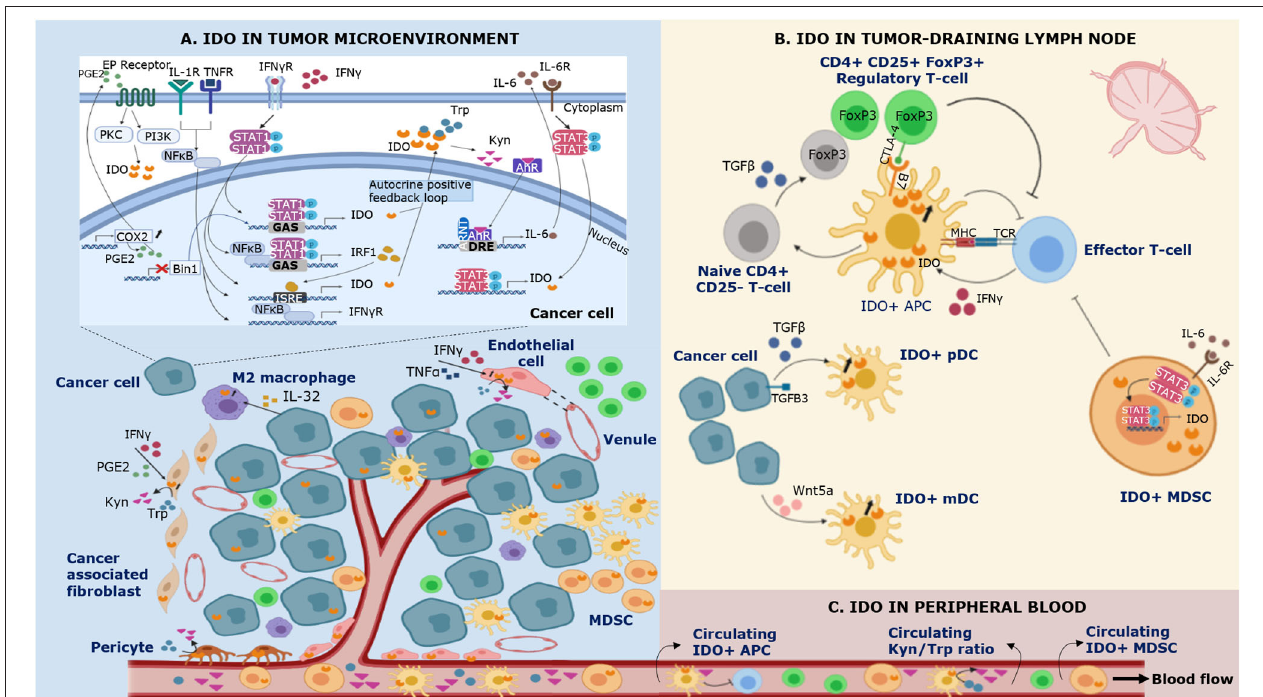
FIGURE 1 | Schematic representation of IDO expression in different compartments of the immune system during cancer. IDO is expressed by multiple cell types in the tumor microenvironment (A) , the tumor-draining lymph node (B) and the peripheral blood (C) . (A) Bin1 attenuation results in STAT1- and NF κ B-dependent constitutive expression of IDO in cancer cells. In addition, COX2 overexpression facilitates constitutive IDO expression via PGE2-mediated activation of the PKC/PI3K pathways. IFN γ is recognized as a highly potent inducer of IDO expression. Binding of IFN γ to its receptor (IFN γ R) leads to (i) tyrosine phosphorylation of STAT-1, triggering its dimerization and binding to the GAS sequence in IDO1 and (ii) NF- κ B and STAT-1 dependent synthesis of IFN γ -regulated factor 1 (IRF1), which binds to the ISRE sequences in IDO1 . Tumor IDO expression activates the cytosolic transcription factor aryl hydrocarbon receptor (AhR) by kynurenine (Kyn), stimulating an autocrine positive feedback loop via IL-6 dependent STAT-3 signaling which maintains IDO expression. In addition to IFN γ , IDO expression can be induced by other proinflammatory cytokines such as tumor necrosis factor α (TNF α ) and IL-1 who enhance the expression of IFN γ R on cancer cells. IFN γ and TNF α can also induce IDO expression in endothelial cells of venules in the tumor microenvironment. In the tumor-surrounding stroma, IDO is expressed by cancer associated-fibroblasts, pericytes, and infiltrating immune cells. (B) Regulatory T-cells (Tregs) induce IDO expression by antigen-presenting cells (APCs) via CTLA-4/B7 ligation in the tumor-draining lymph node. In addition, cancer cells are involved in the upregulation of IDO expression in plasmacytoid dendritic cells (pDCs) by shedding of the extracellular domain of the type III TGF-B receptor (sTGFBR3). IDO expression in myeloid DCs (mDCs) can be induced by cancer cell-secreted Wnt5a, which triggers binding of β -catenin to its responsive elements. IDO + APCs inhibit T-cell responses and polarize naïve CD4 + T-cell differentiation toward the phenotype of suppressive Tregs via TGF β -mediated FoxP3 upregulation. Myeloid derived suppressor cells (MDSCs) upregulate IDO via IL-6 triggered STAT-3 activation. (C) IDO + APCs and IDO + MDSCs infiltrate the tumor microenvironment and the peripheral blood, contributing to local and systemic immune